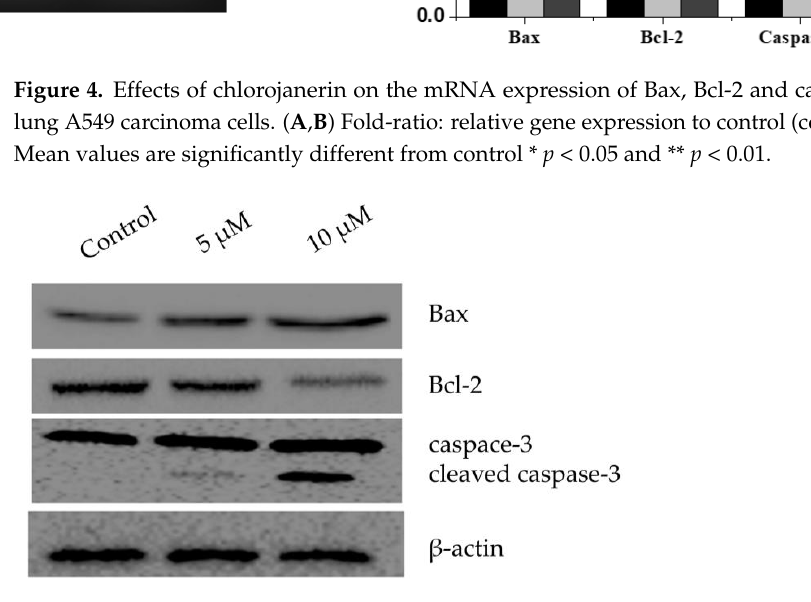
Figure 4. Effects of chlorojanerin on the mRNA expression of Bax, Bcl-2 and caspase-3 in human lung A549 carcinoma cells. ( A , B ) Fold-ratio: relative gene expression to control (control fold ratio: 1). * Mean values are significantly different from control * p < 0.05 and ** p < 0.01.